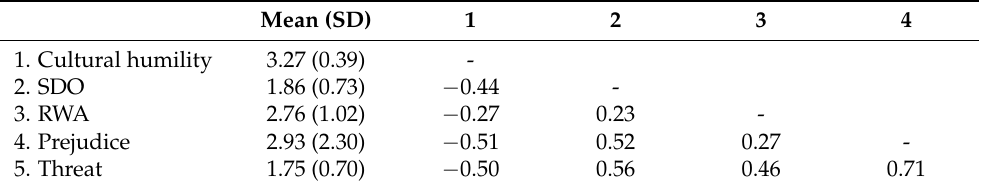
Table 1. Means, standard deviations, and correlations between